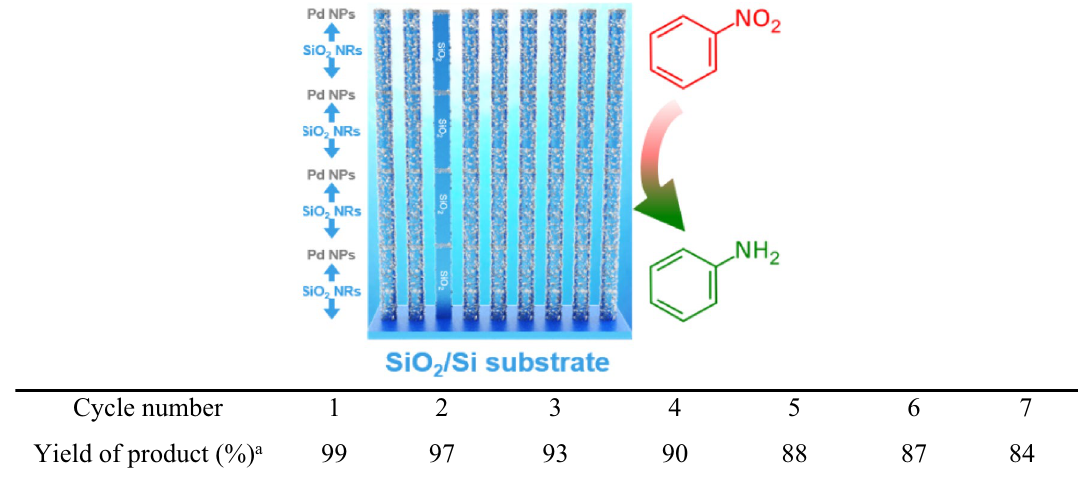
Table 3. Reuse of v-SiO 2 NRs@Pd nanostructured catalyst in the heterogeneous reduction of nitrobenzene. Reaction conditions: Substituted nitroarenes (0.1 mmol), NaBH 4 (0.12 mmol), v-SiO 2 NRs@Pd nanostructured catalyst (1 mol% Pd), H 2 O (20 mL), room temperature, and 1.5 h. a Yields were determined by